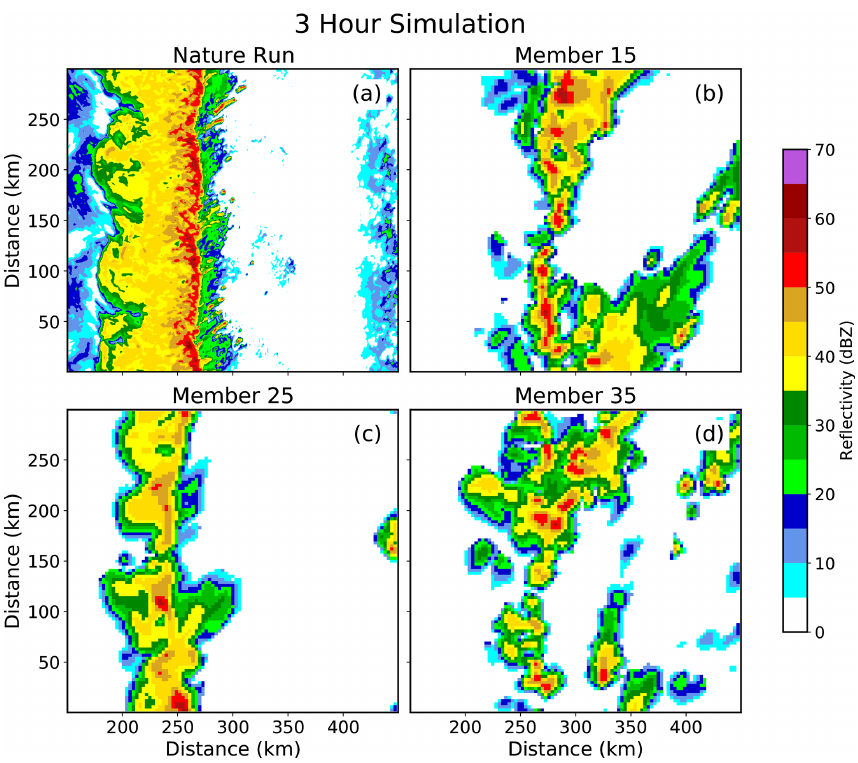
Figure 8. (a) Nature run and (b–d) forecast Z at the lowest model level at 03:00UTC. The forecasts are integrated forward in time without data assimilation.